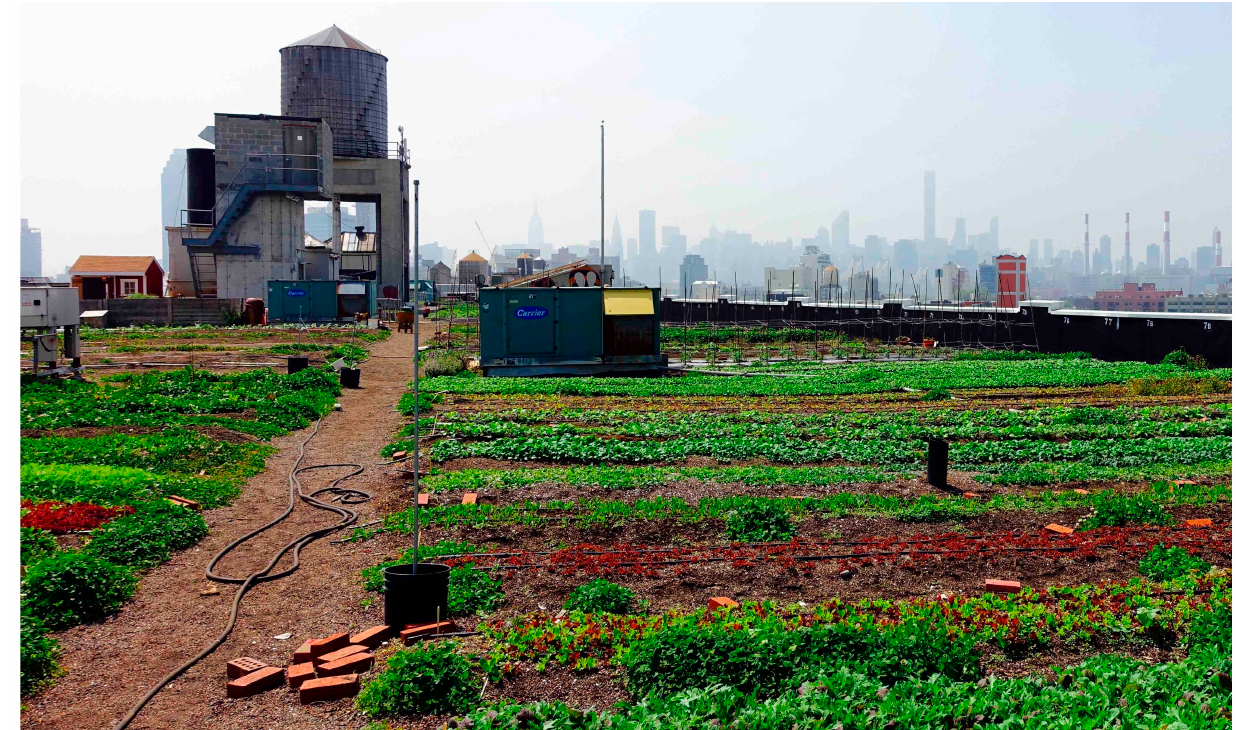
Figure 10. View of Brooklyn Grange, New York City. This project demonstrates a green infrastructure approach, reducing stormwater and urban heat island effect. Image from authors.